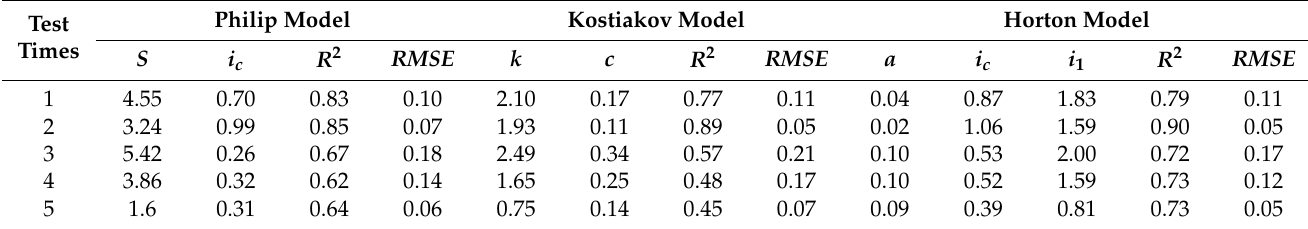
Table 4. Model parameters of the Philip, Kostiakov, and Horton models for simulation of soil water